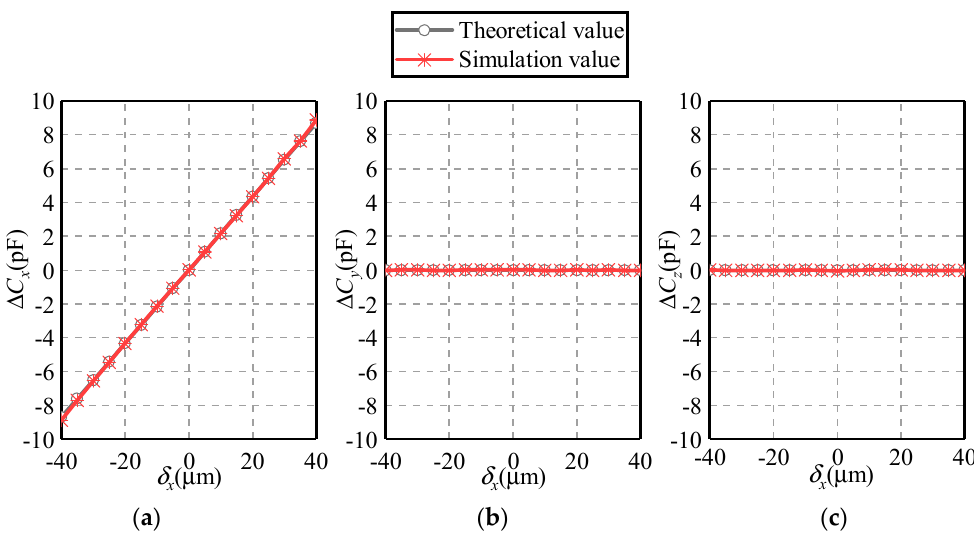
Figure 11. Dependence of the di ff erential capacitance on the eccentric displacement along the X -axis Figure 11 . Dependence of the differential capacitance on the eccentric displacement along the ( a ) ∆ C x , ( b ) ∆ C y and ( c ) ∆ C z . X -axis ( a ) Δ C x , ( b ) Δ C y and ( c ) Δ C z .